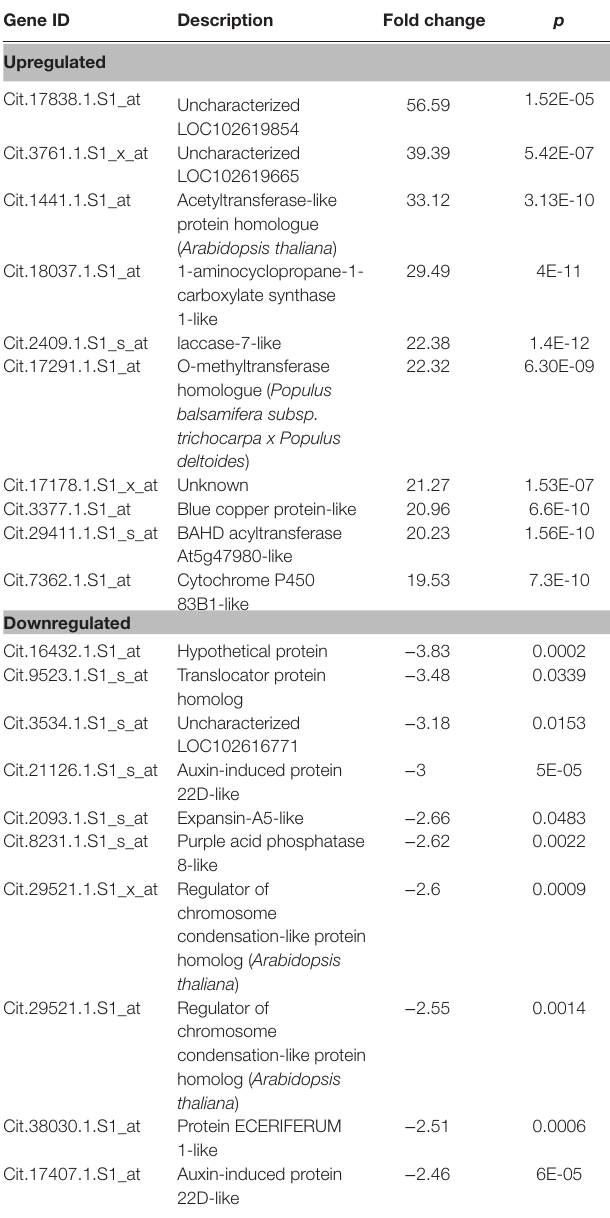
TABLE 4 | A sample of the differentially expressed genes in the control vs. MFA- treated